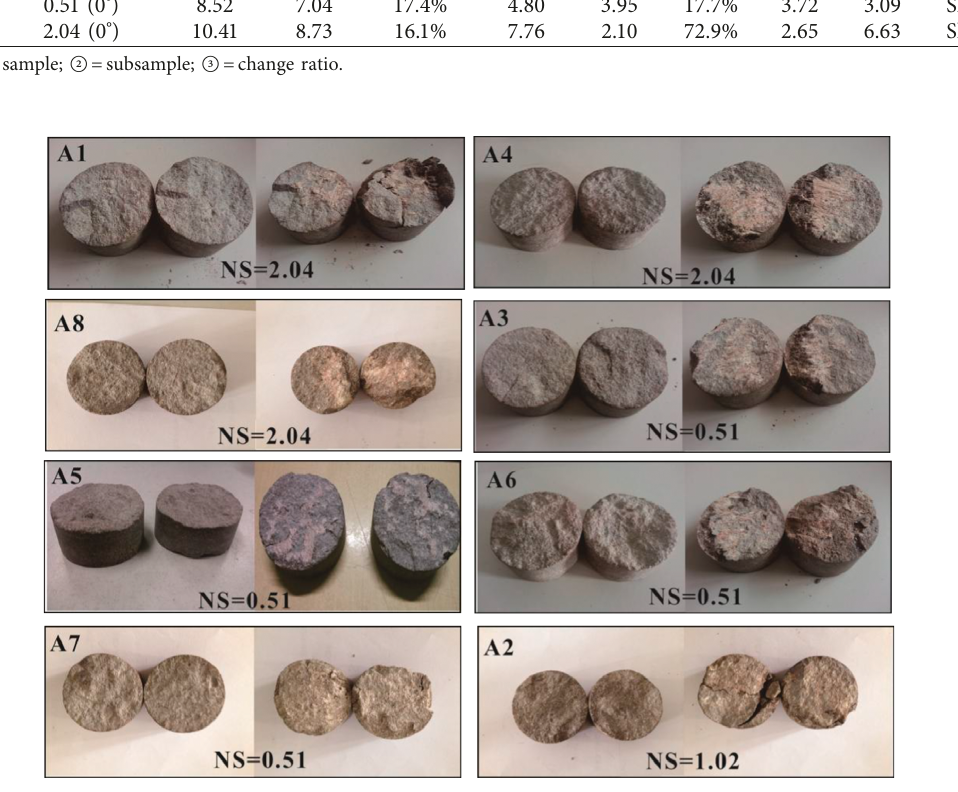
Figure 22: Roughness surfaces of the samples before and after the experiment.